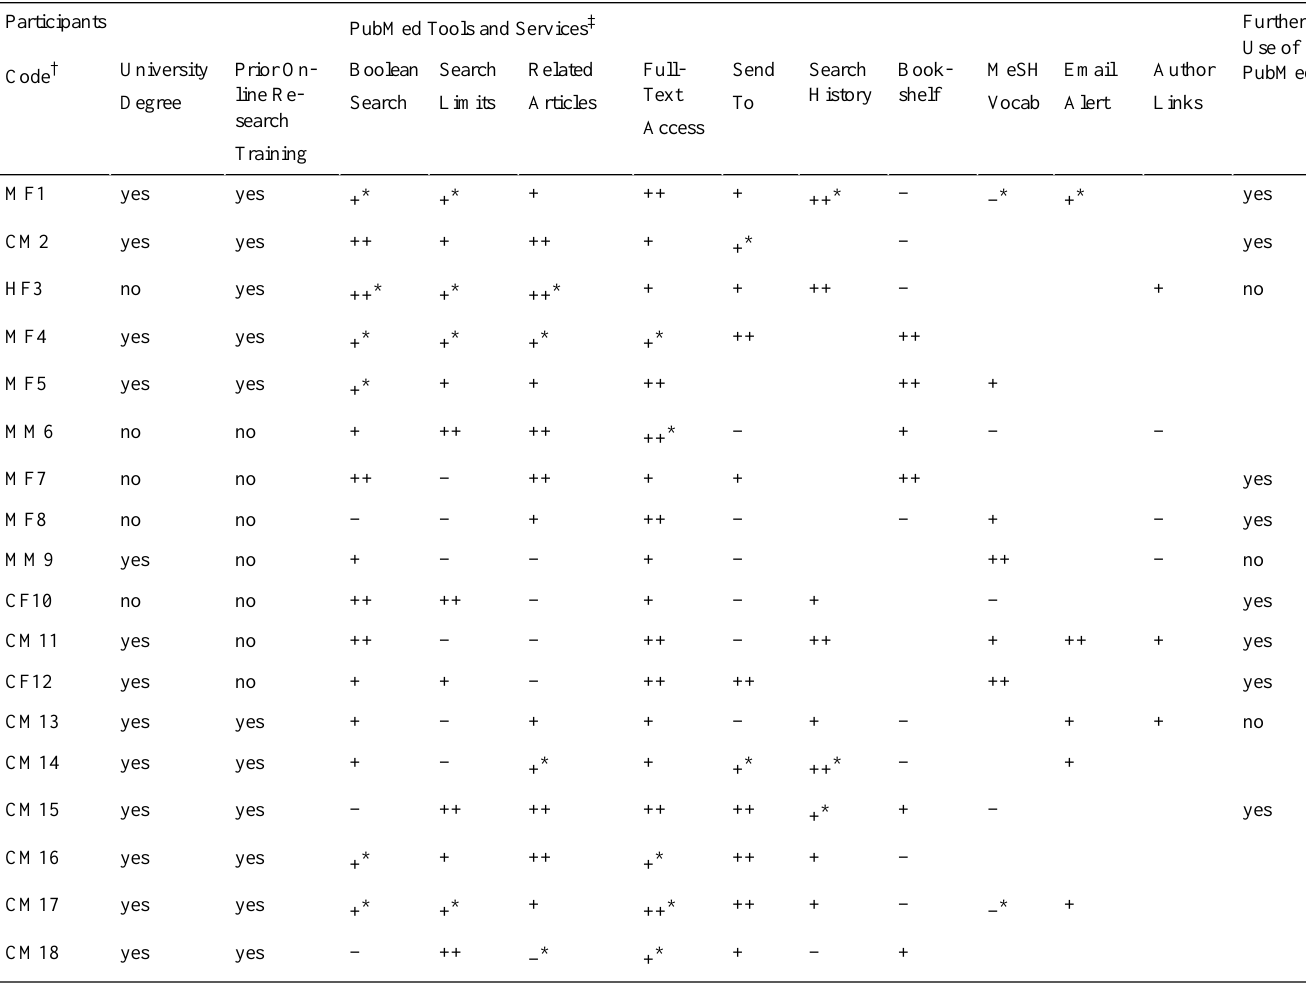
Table 2. Value of PubMed tools and services for participants (N = 18)